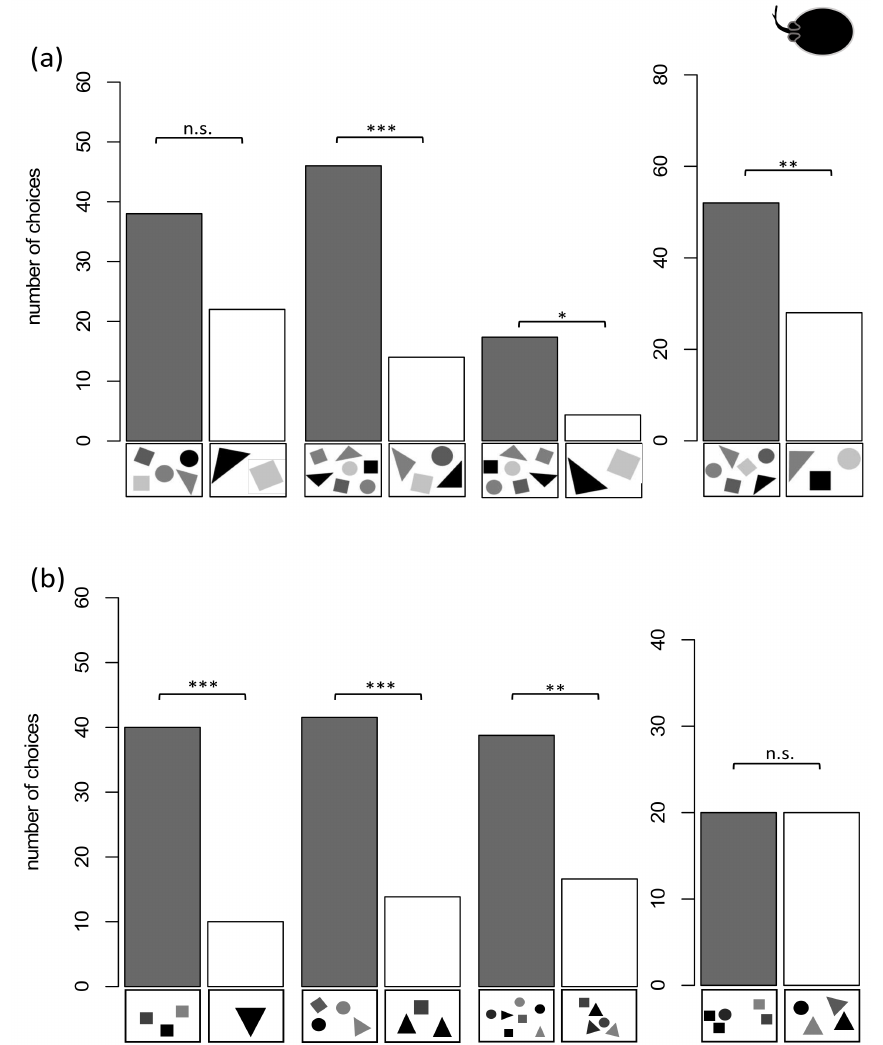
Figure 7. Overview of stingray groups 3 and 4 and their results in the transfer tests. On the X- Axis exemplary stimuli-pairs are displayed. The dark bars represent the correct choice for higher numerosity. p > 0.05 not significant (n.s.), p < 0.05 significant (*), p < 0.01 significant (**), p < 0.001 significant (***). ( a ) Results for group 3, ( b ) Results for group